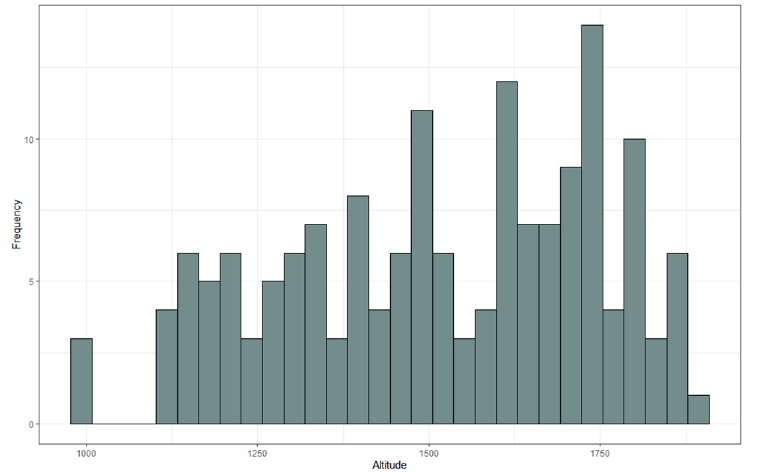
Figure 2. Frequency histogram of altitude for the 163 selected stations. Source: authors’ processing.